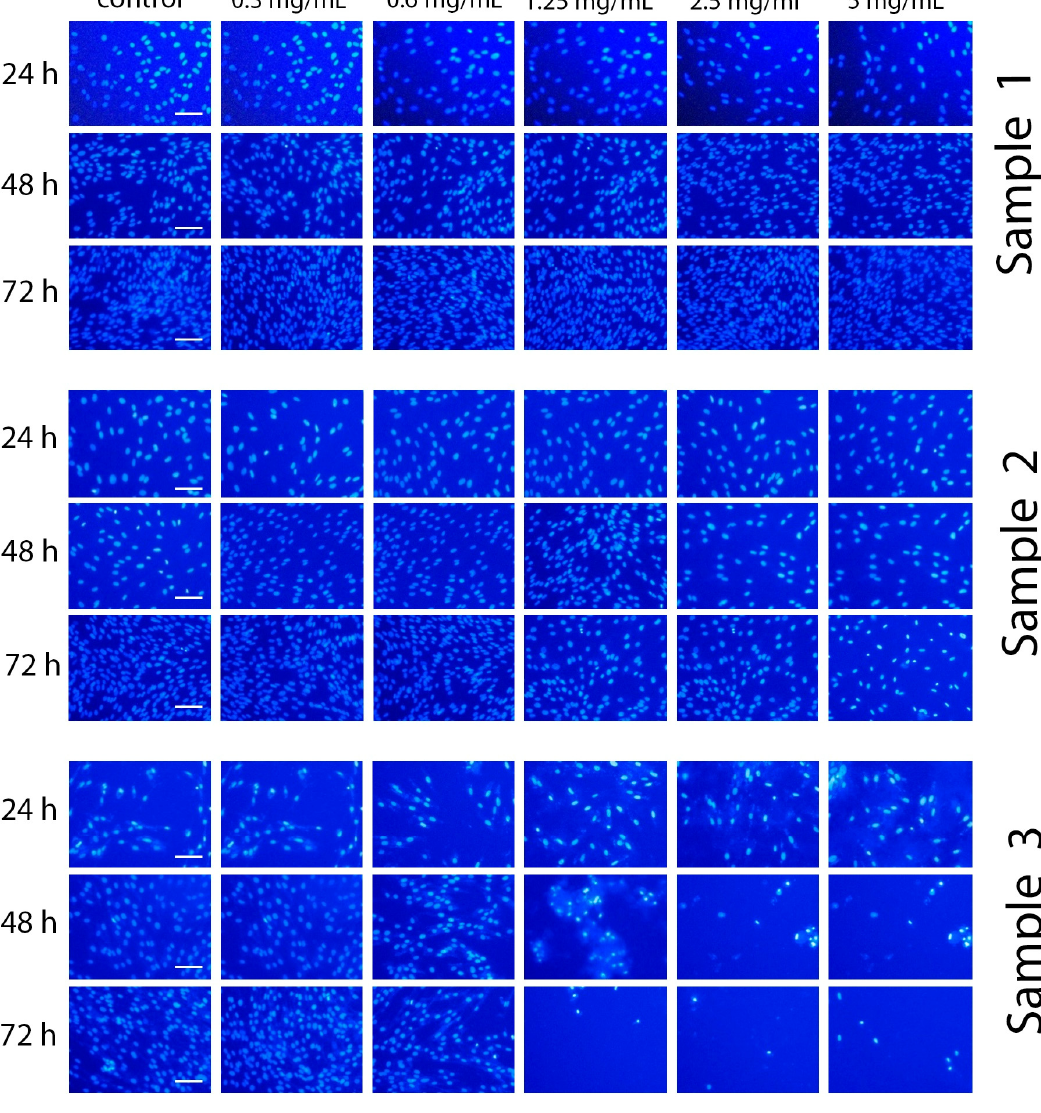
Figure 8. Micrographs of hMSc after 24, 48 and 72 h of incubation with Ce 0.8 Gd 0.2 O 2 − x nanoparticles (0.3–5 mg/mL) and a quantitative estimation of the proportion of cells with nuclear apparatus abnormalities (fragmentation or change in the morphology of the nucleus) after 72 h of cultivation (staining with Hoechst 33342). All the images were taken at the same magnification. Scale bar is 100 µ m.